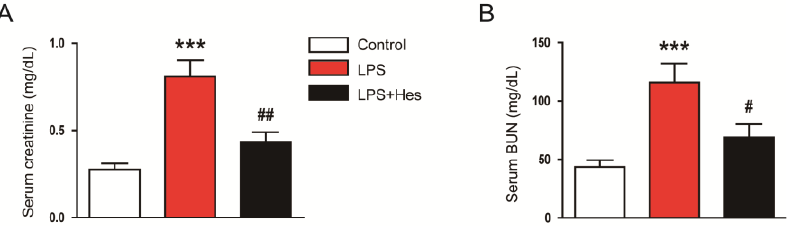
Figure 3. Hesperetin attenuated renal dysfunction in LPS-injected mice. ( A ) Serum creatinine. ( B ) Serum blood urea nitrogen (BUN). n = 8 per group. *** p < 0.001 vs. Control. # p < 0.05 and ## p < 0.01 vs. LPS.